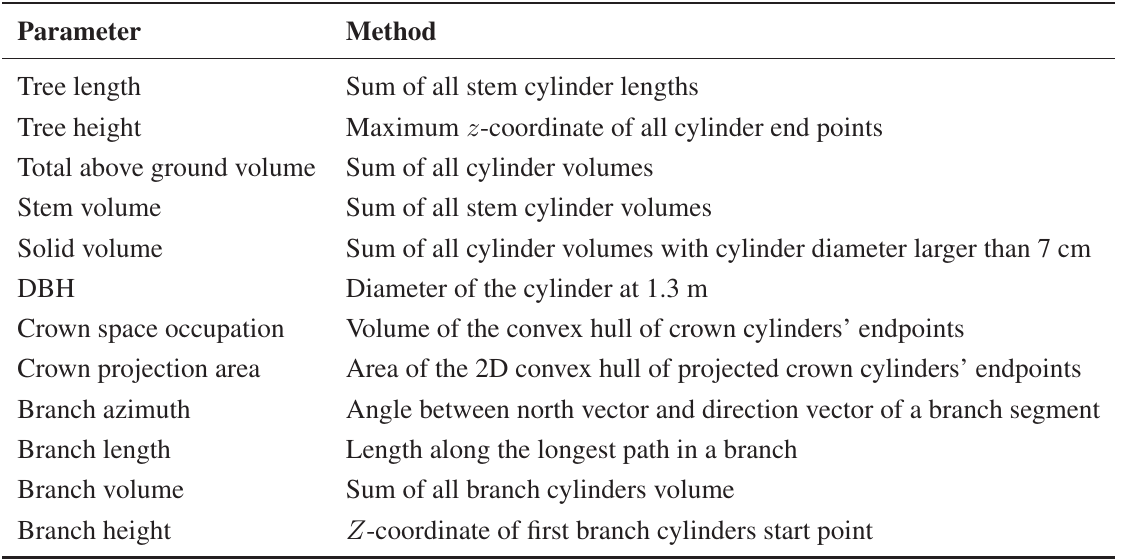
Table 3. Output parameters derived from the final tree